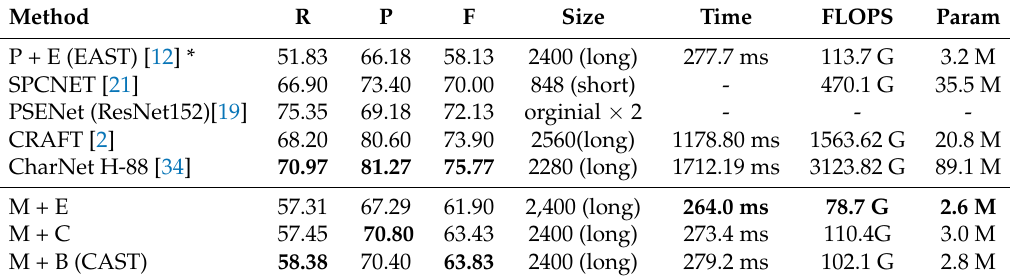
Table 3. Results with ICDAR2017 MLT dataset, where R , P , and F represent the recall, precision, and F1 score, respectively. An asterisk(*) indicates that the corresponding result is obtained in our own experiment. M and P denote MobilNetV2 and Pvanet, respectively. E, C, and B are the EAST decoder, the CRAFT decoder, and our proposed balanced decoder, respectively. The inference time